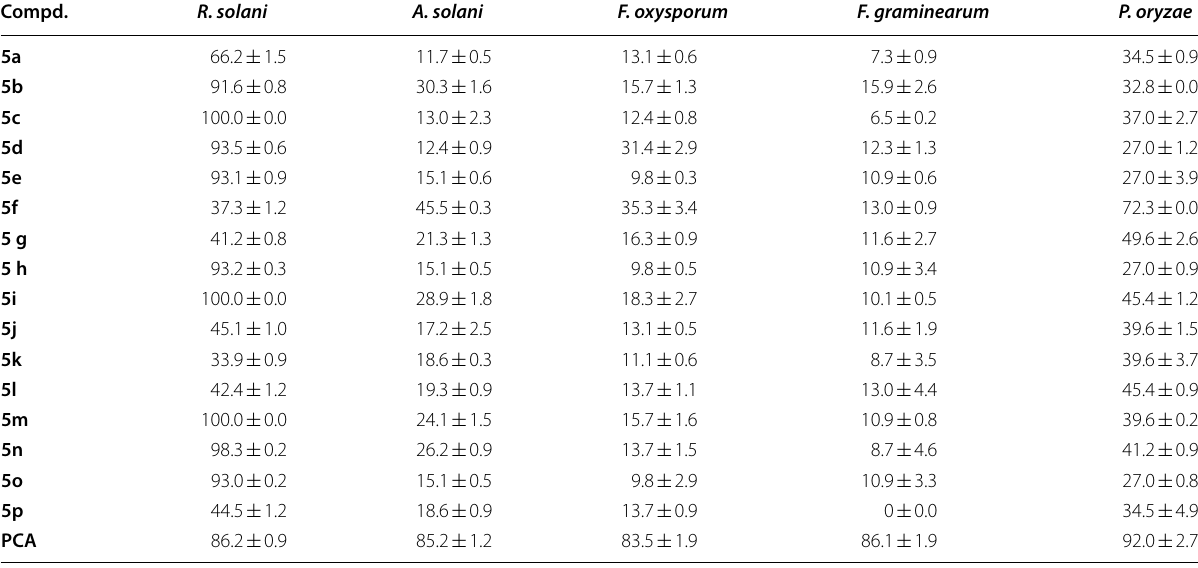
Each treatment had three replicates (Mean